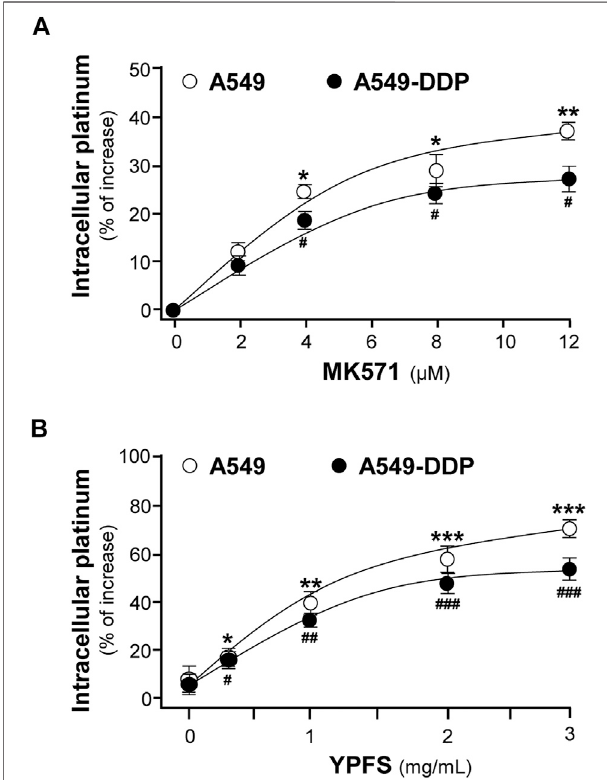
FIGURE 1 | YPFS increases intracellular platinum in cultured A549 and A549-DDPcells. Cultured A549and A549-DDPcells(500,000) wereplated in a 100-mm culture plate and cultured to 90% con fl uent. Then, cells were challenged with 2.5 µM cisplatin (non-toxic dose) and MK 571 (A) or YPFS extract (B) for 3 h. After washing, the collected cells were digested with 500 μ l 70% HNO 3 spiked with 40 μ g/ml cadmium for 2 h and adjusted with water to 3 ml and subjected to ICP-OES analysis. Values are normalized with total protein and cadmium signal, expressed as % of increase as compared withcontrolgroup(nodrug),inmean ± SEM, n (cid:2) 3.*or # , p < 0.05,**or ## , p < 0.01, *** or ### , p <